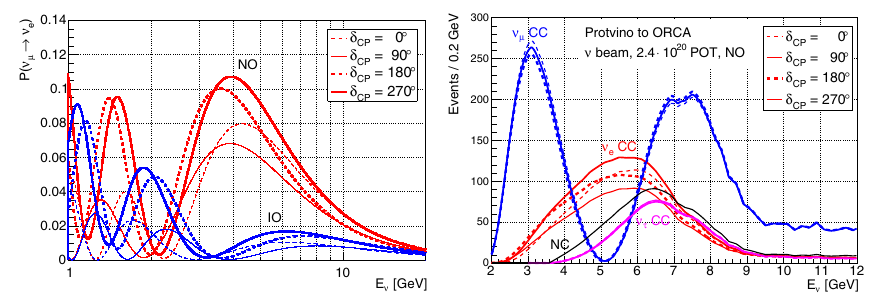
ν e (electron neutrino appearance) for baseline L = → 10 20 POT. The case of ·